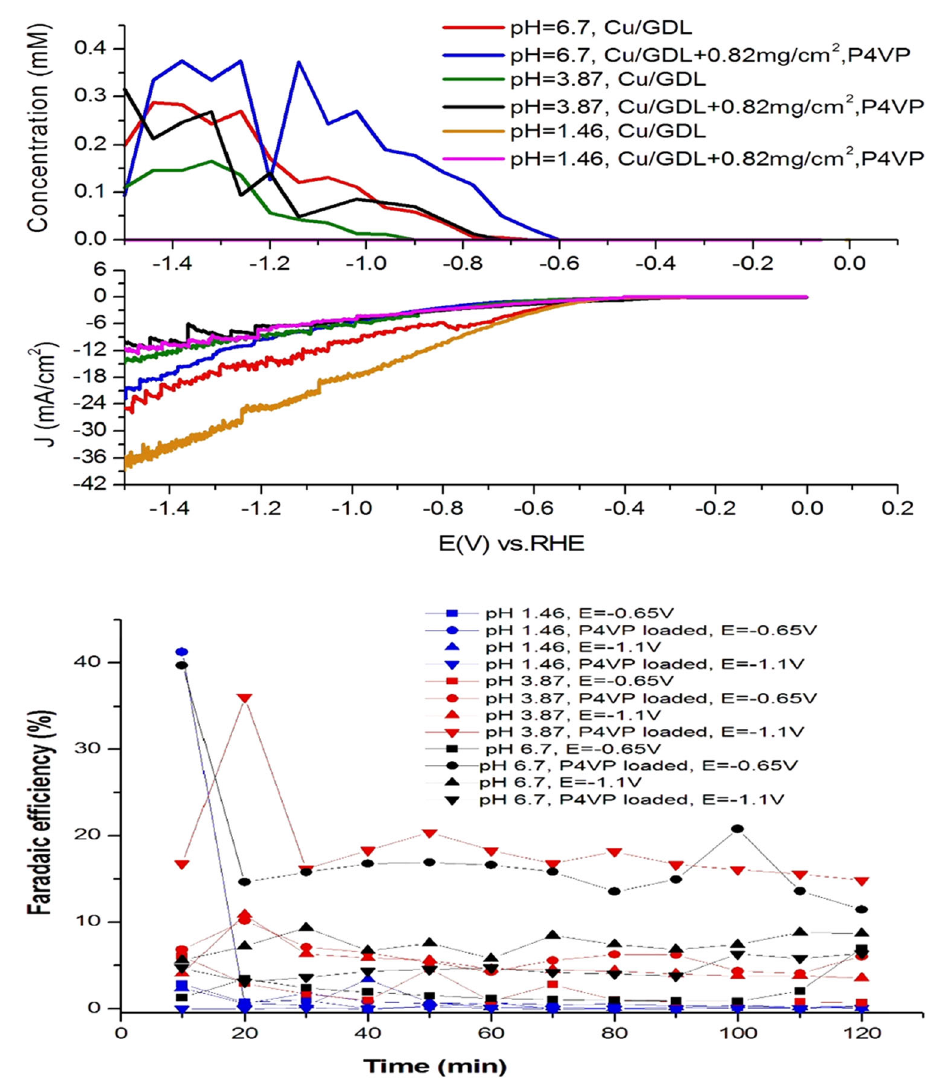
Fig. 6 Effect of electrolyte pH on voltammetric behavior and formic acid production activity of unmodified and P4VP modified Cu/GDL electrodes.